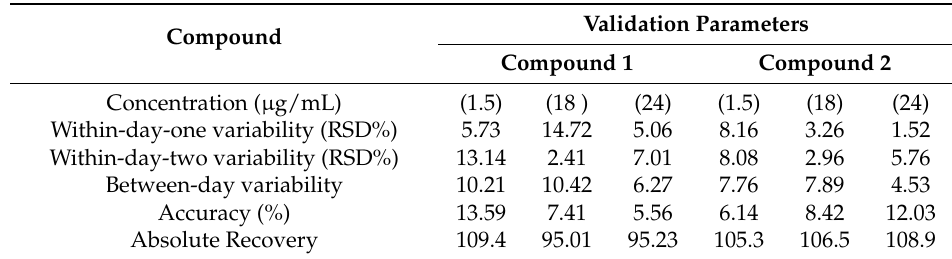
Table 3. Chromatographic parameters and validation results for the quantification method used for both Compound 1 and Compound 2 .